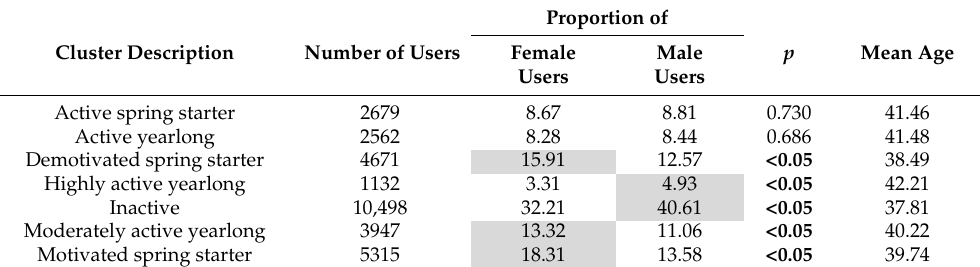
Table 3. Demographic characteristics of k-means yearlong physical activity behaviour clusters. Bold font indicates a statistically significant associating, significantly higher proportions are shaded